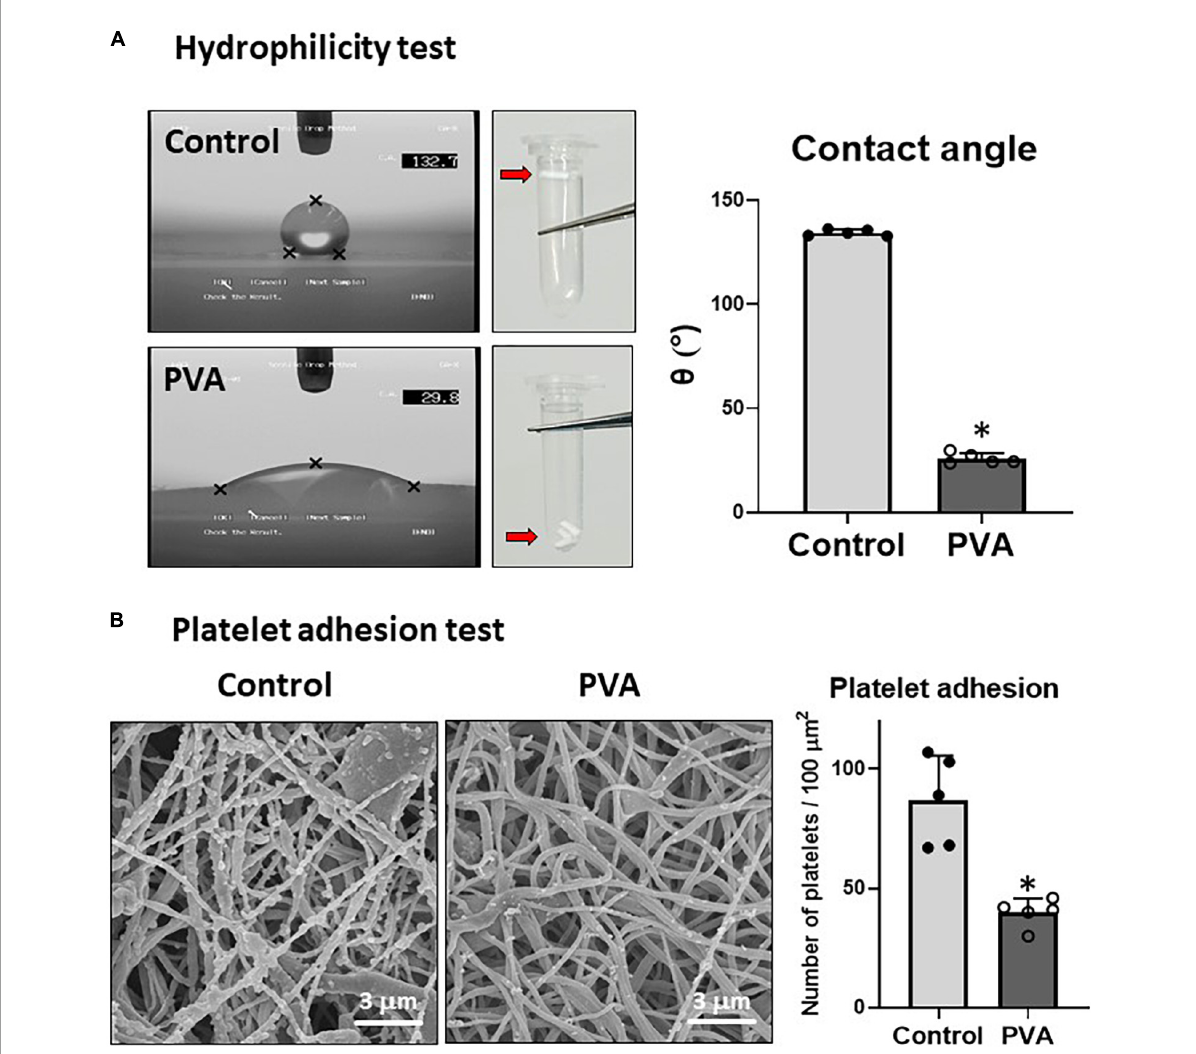
FIGURE3 Hydrophilicity and platelet adhesion tests. (A) Hydrophilicity test. The hydrophilicity of the control and PVA–PCL surfaces was measured through the sessile drop contact angle method. The sessile drop was imaged using an angle meter. Independent measurements were repeated five times, and the representative images from each group are shown on the left. Three grafts were soaked in PBS, and the results are shown at the center of the figure. The contact angle results are shown on the right. The graphs are expressed as mean ± SD, and the data points represent the individual values in each group. ∗ Represents p < 0.05. (B) Platelet adhesion test. Human plasma was passed through the grafts. After flushing with PBS, the adsorbed platelets were imaged using SEM. The independent tests were repeated five times, and the representative images are shown on the left. Numerical results are shown on the right. The graphs are expressed as the mean ± SD, and the data points represent the individual values in each group. ∗ Represents p <